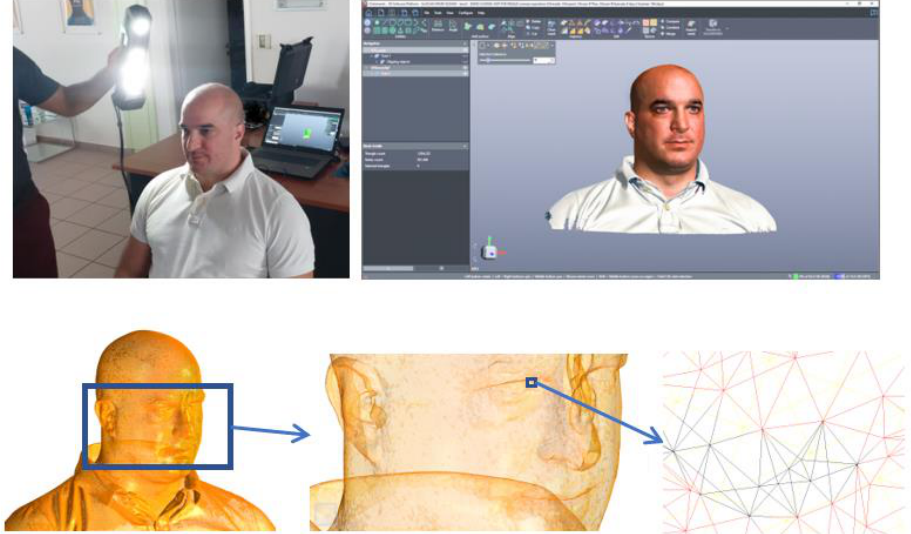
Figure 3. Face modeling process: Face scanning and mesh model processing ( top ), and export in STL form.